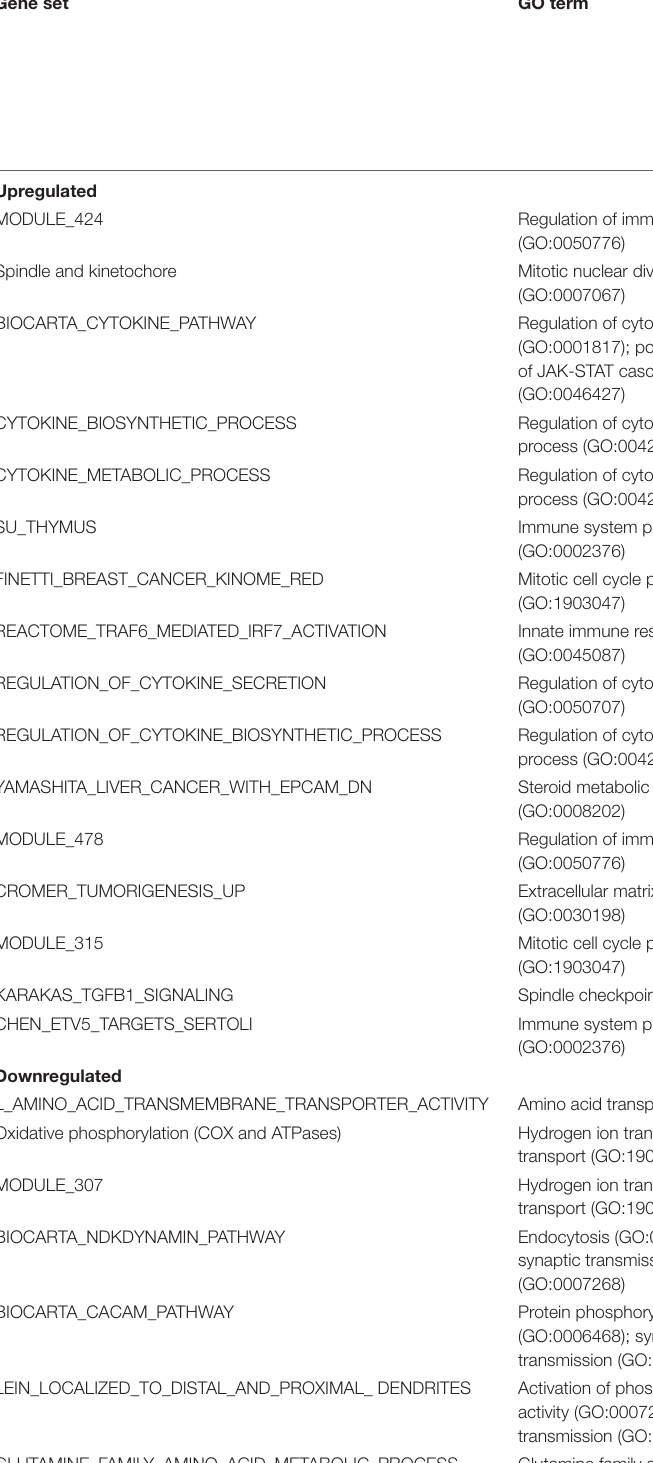
TABLE 2 | Top gene sets in TREM2 R47H brains are enriched by immunity-related GO terms. Gene